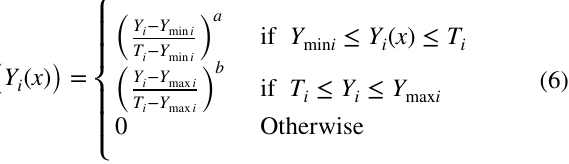
Table 6 Optimization parameters used in this study, such as the importance, the upper and lower values of each function